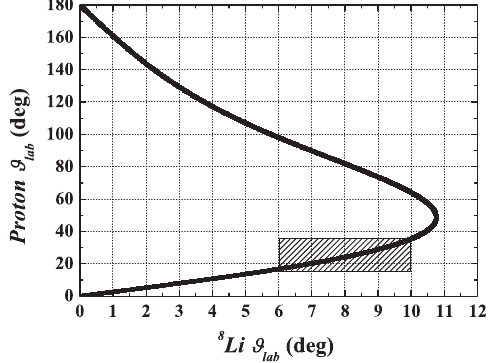
FIG. 19. Neutron angular distribution in the center of mass frame of the 6 Li ð 3 He ; n Þ 8 B reaction. The solid line is the result of theoretical predictions based on the DWUCK 4 code.